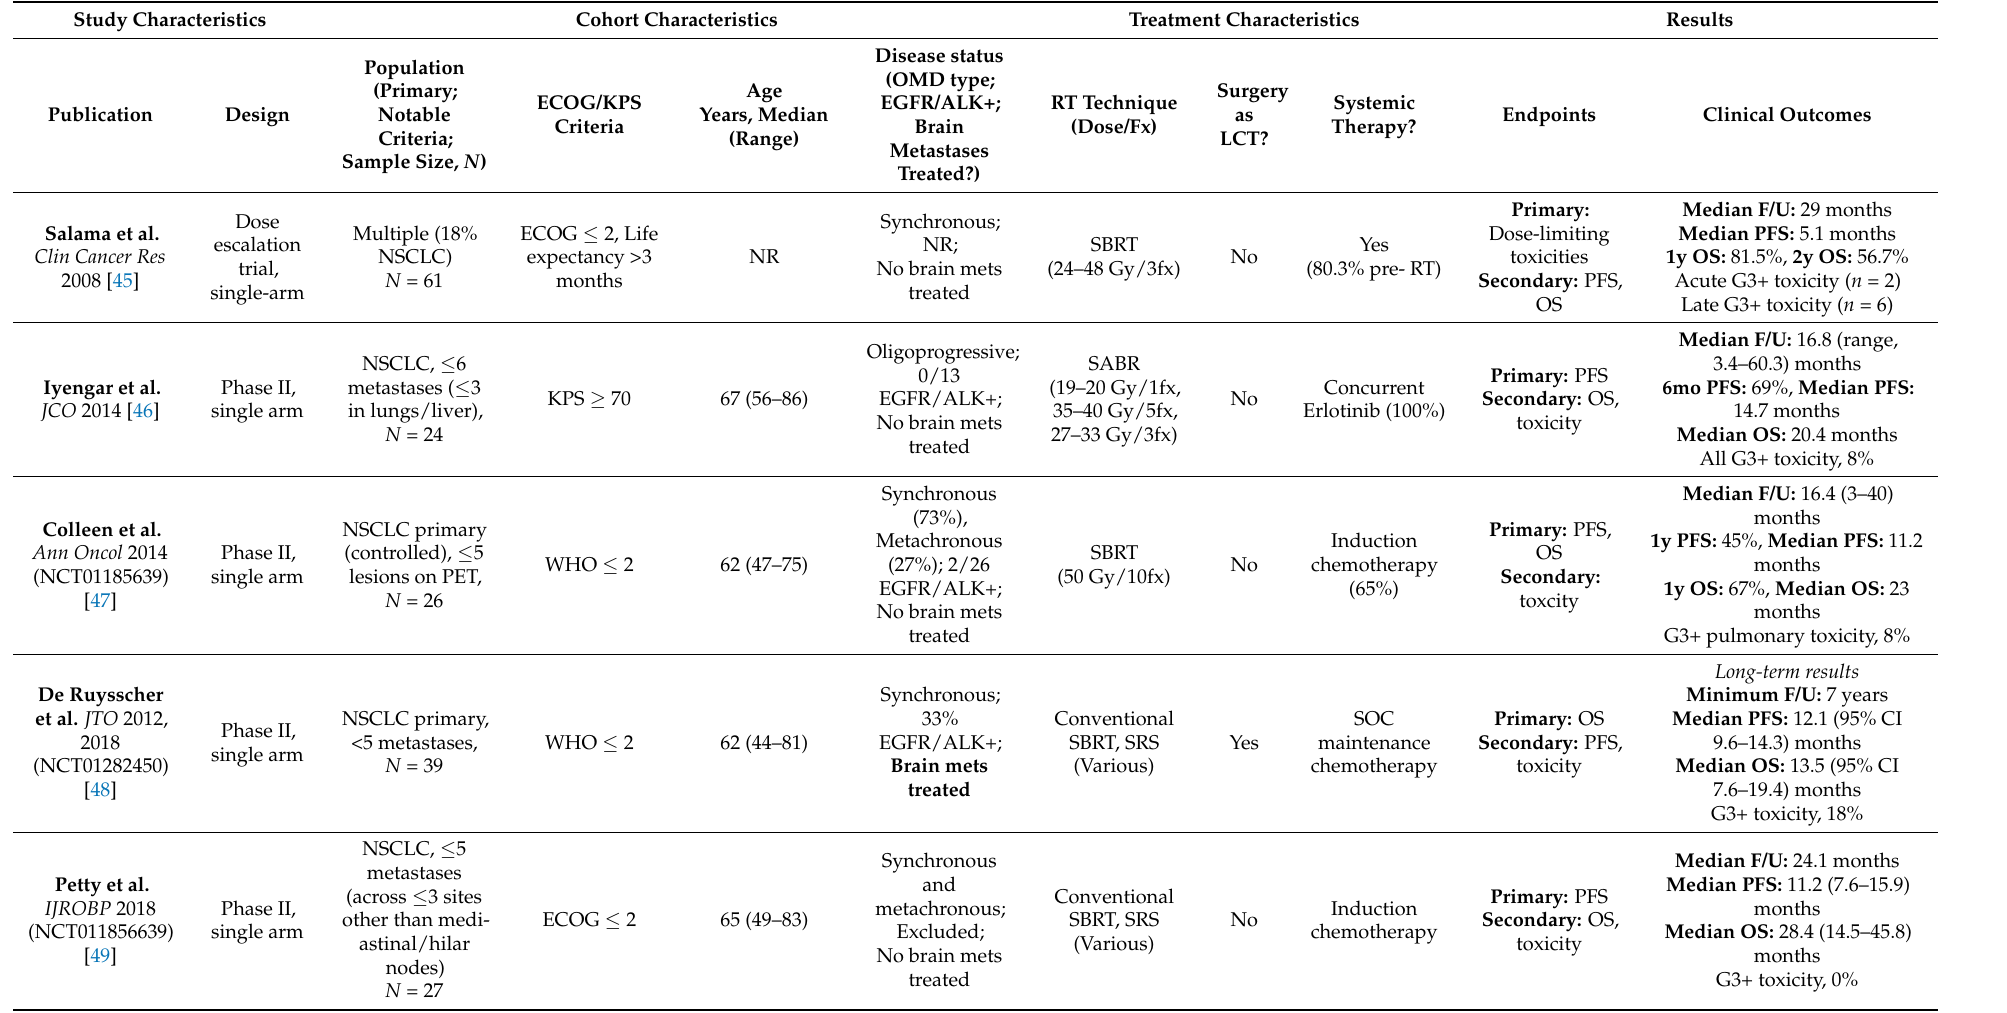
Table 2. Phase II single-arm and randomized control trials of LCT in oligometastatic